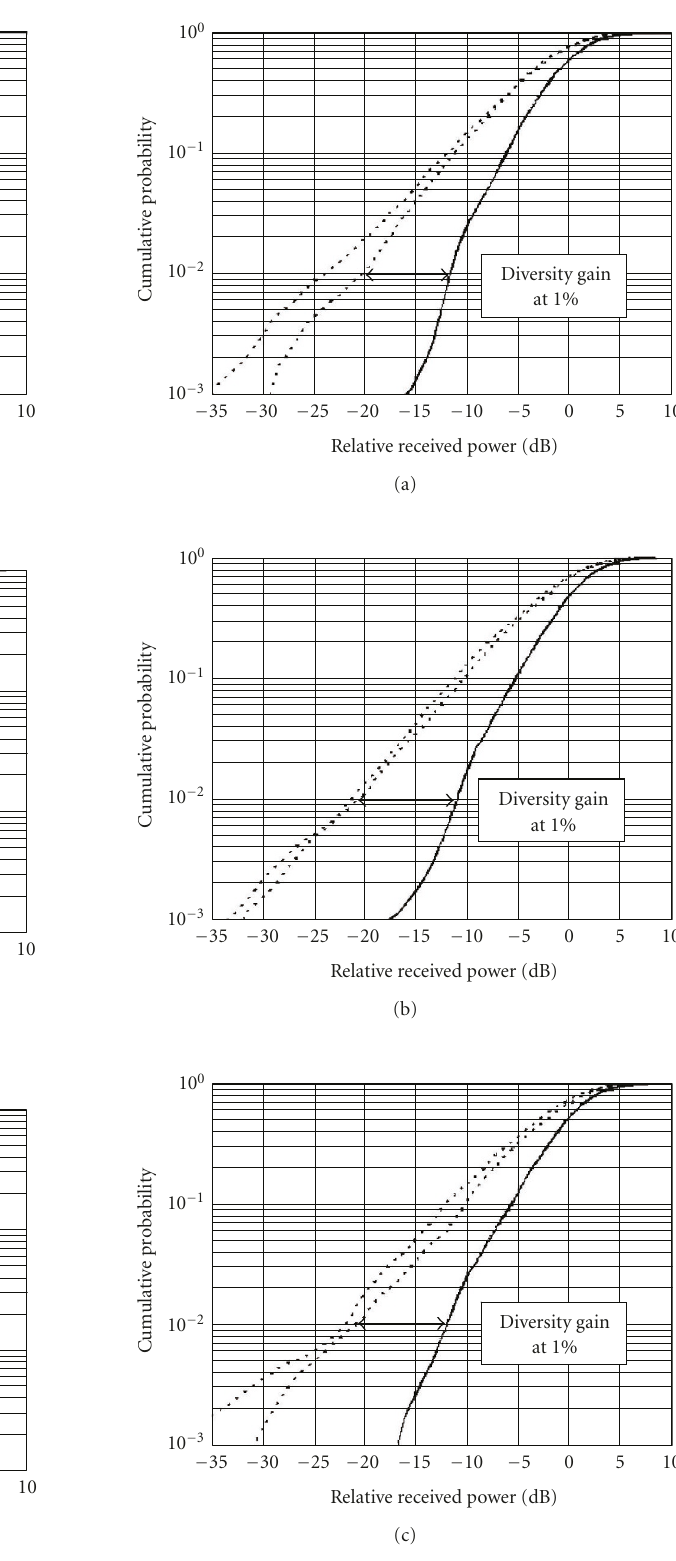
Figure 10: Smoothed cumulative probability of the two-antenna systems over a 4MHz bandwidth at 2GHz: (a) without the neu- tralization line, (b) with the neutralization line between the feed- ing strips, and (c) with the neutralization line between the shorting